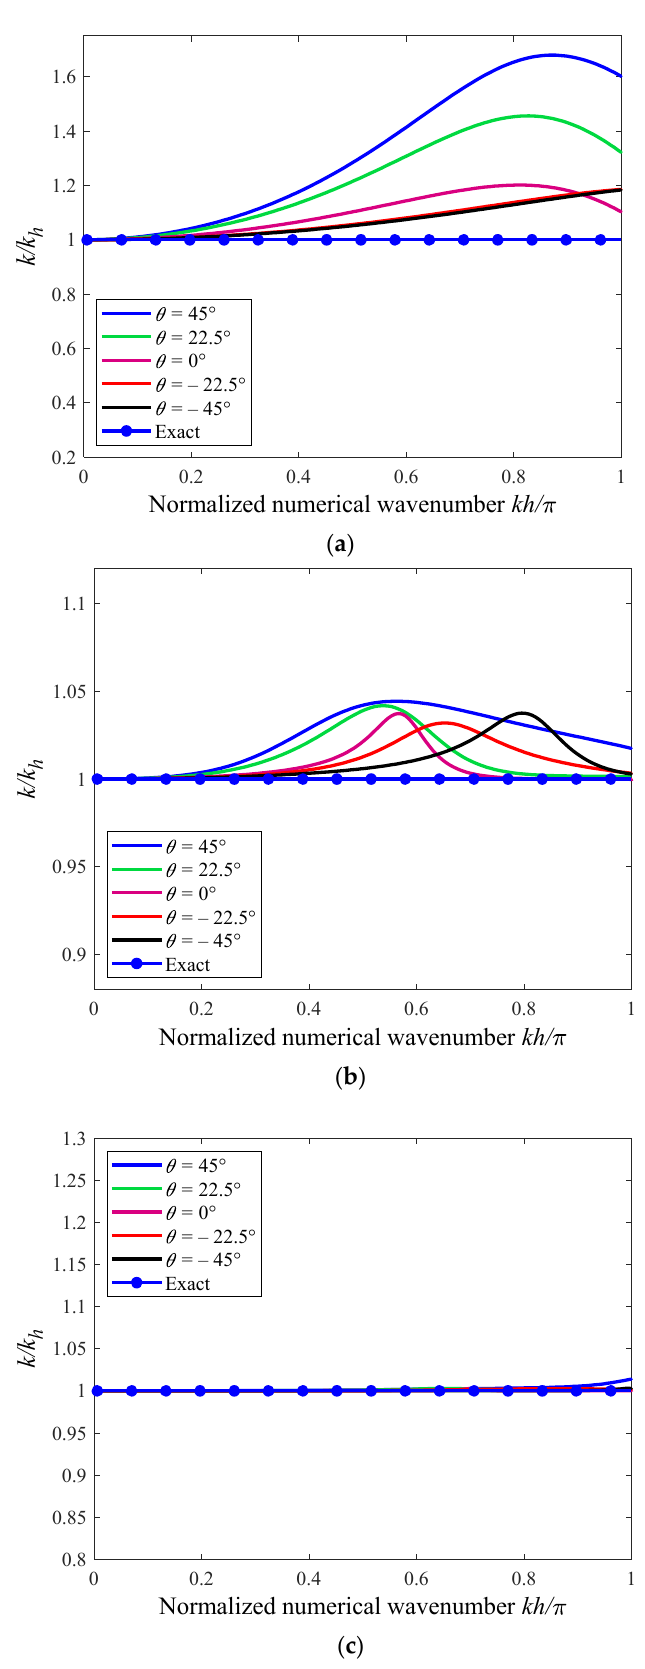
Figure 3. The numerical dispersion error along the varying angles of acoustic wave propagation from di ff erent discretization techniques: ( a ) FEM-T3; ( b ) EFEM-N9; ( c ) EFEM-N11. Additionally, it is also clear that the dispersion e ff ects from the standard FEM-T3 di ff ers quite much when the varying wave propagation angles are considered, namely the standard FEM-T3 usually su ff ers from the numerical anisotropy issue in tackling the Helmhol tz equation. The EFEM using the fi rst order of trigonometric enrichment func- tions (EFEM-N9) is able to provide much smaller dispersion error results than the stand- ard FEM-T3, while the EFEM-N9 still su ff ers from the above-mentioned numerical anisot- ropy issue and the numerical dispersion e ff ects are also markedly di ff erent along di ff erent angles of wave propagation. In contrast to the standard FEM-T3 and EFEM-N9, the EFEM with linear polynomial and the fi rst order of trigonometric enrichment functions (EFEM- N11) can yield the smallest dispersion error results which are almost zero in the computed normalized wave number range. More importantly, we also can observe that the above- mentioned numerical anisotropy issue can be basically eliminated by this EFEM-N11. The above fi ndings show that it is quite suitable to enrich the linear numerical approximation space of the standard FEM by using the combination of the polynomial and trigonometric